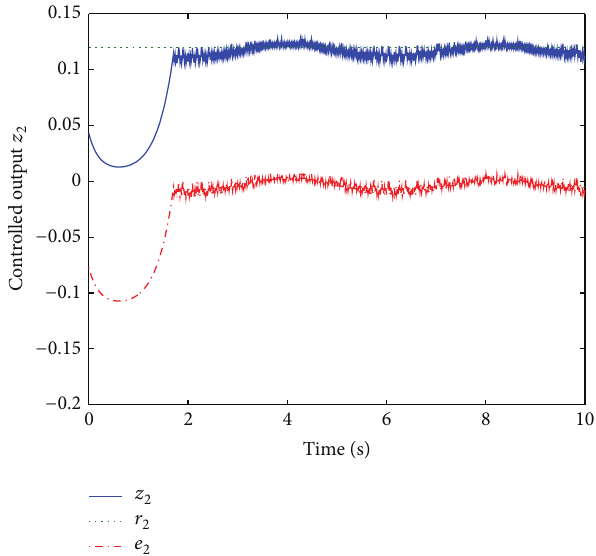
Figure 1: The disturbance 𝑑 and the approximation output of